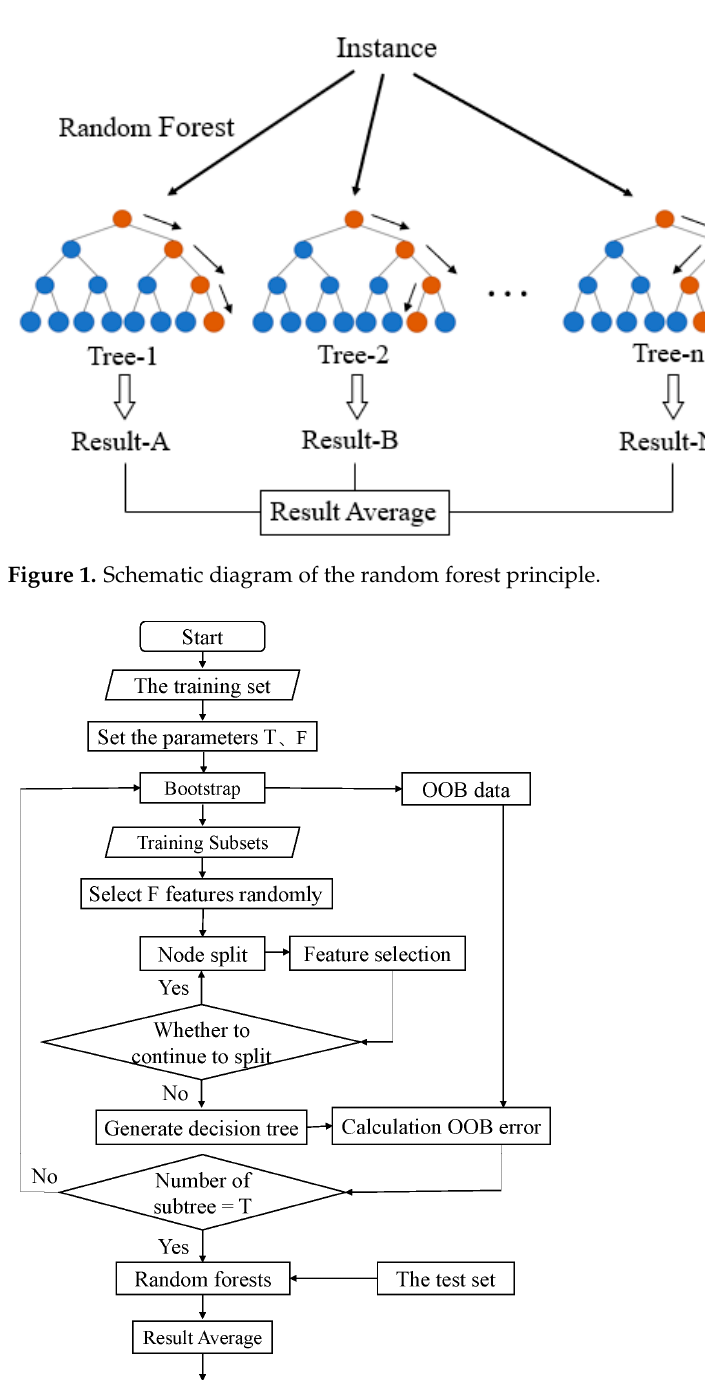
Figure 1 . Schematic diagram of the random forest principle.